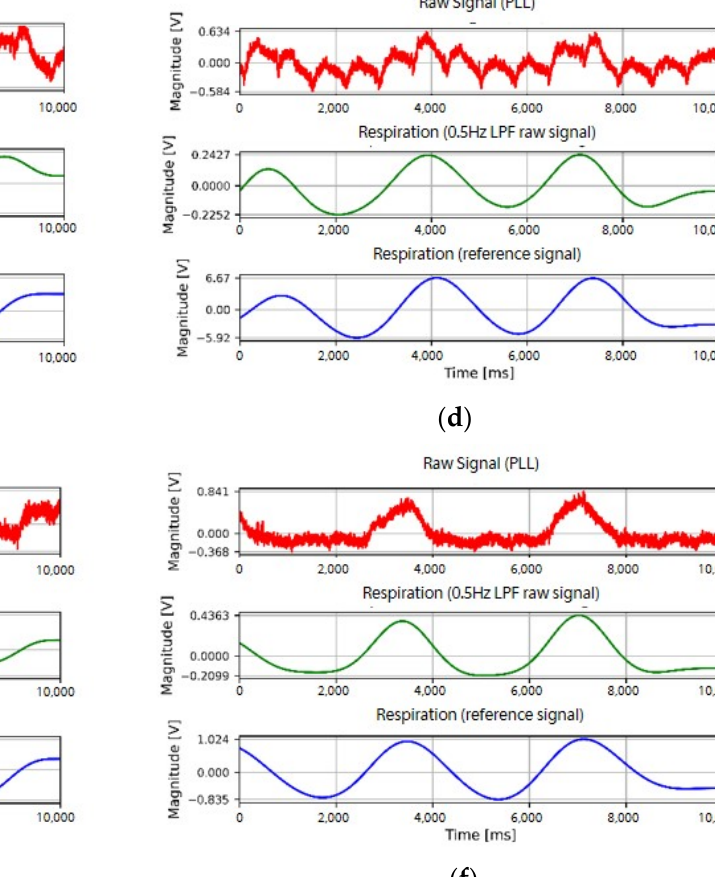
Figure 9. Respiration signals according to the shape and measurement position of the fabric loop sensor: spiral loop sensor at ( a ) P2, ( b ) P4, and ( c ) P6; ( d ) spiral, ( e ) extrusion, and ( f ) spiky loop sensors at P4.